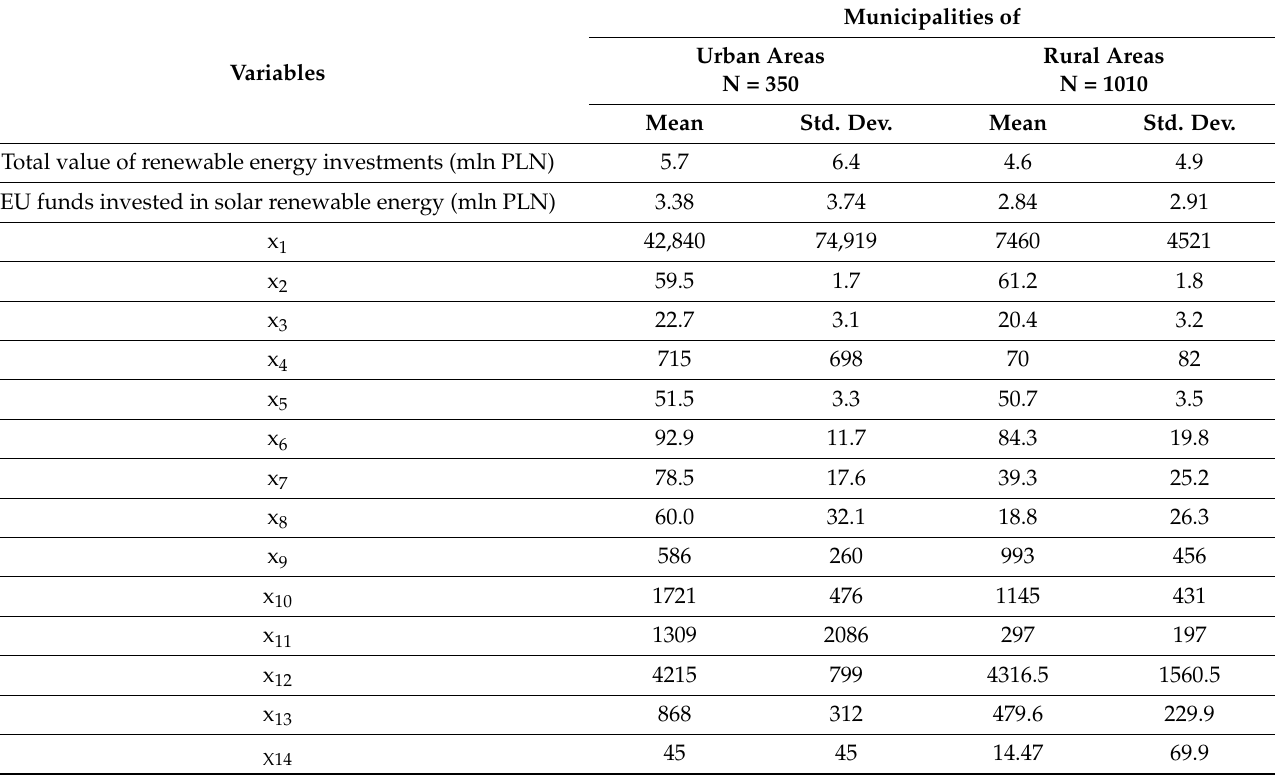
Table 7. Descriptive statistics for urban (N = 350) and rural (N = 1010) municipalities where solar renewable investments were located. Variables